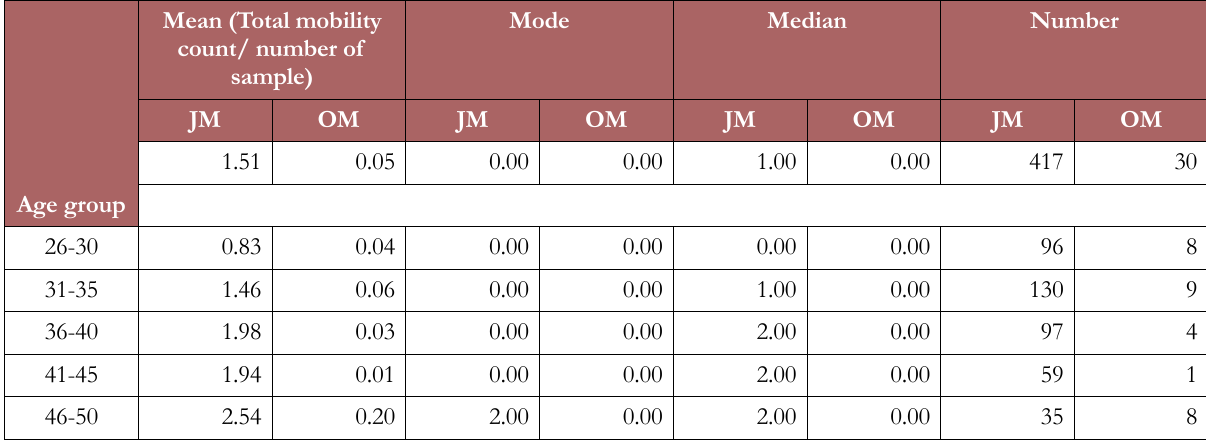
Table 2. Job mobility descriptive